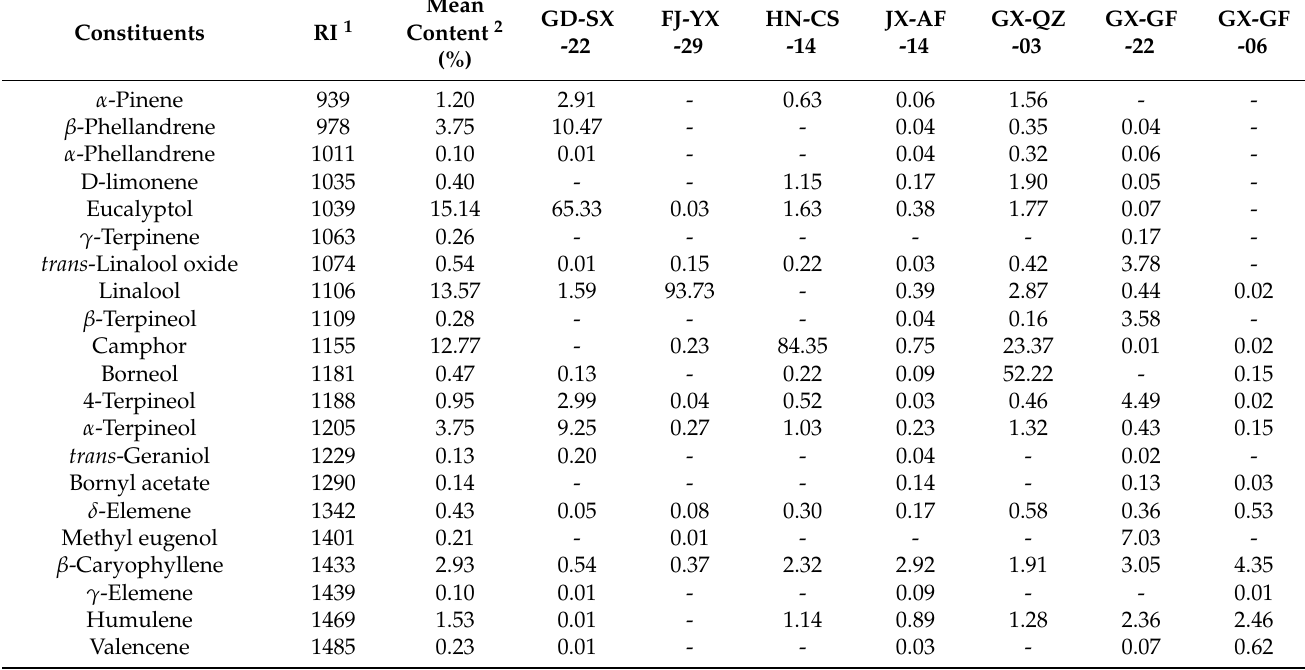
Table 3. Relative content of 41 compounds in essential oil and samples with different